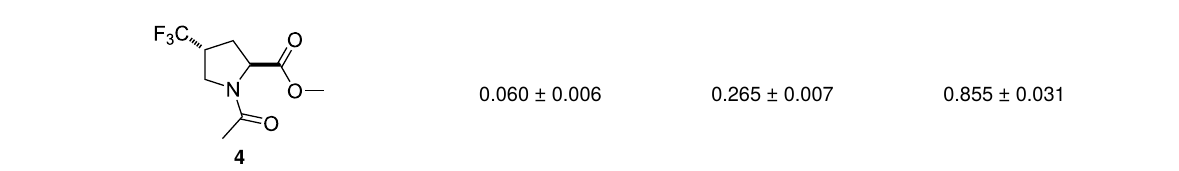
0.060 ± 0.006 0.265 ± 0.007 0.855 ± 0.031 4